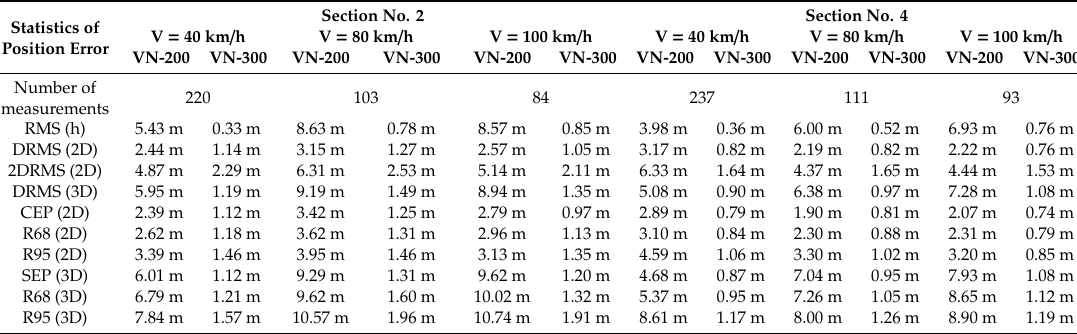
Table 7. Predictable positioning accuracy of VN-200 and VN-300 systems during Inertial Navigation System (INS) measurements in Gda´nsk in sections no. 2 and